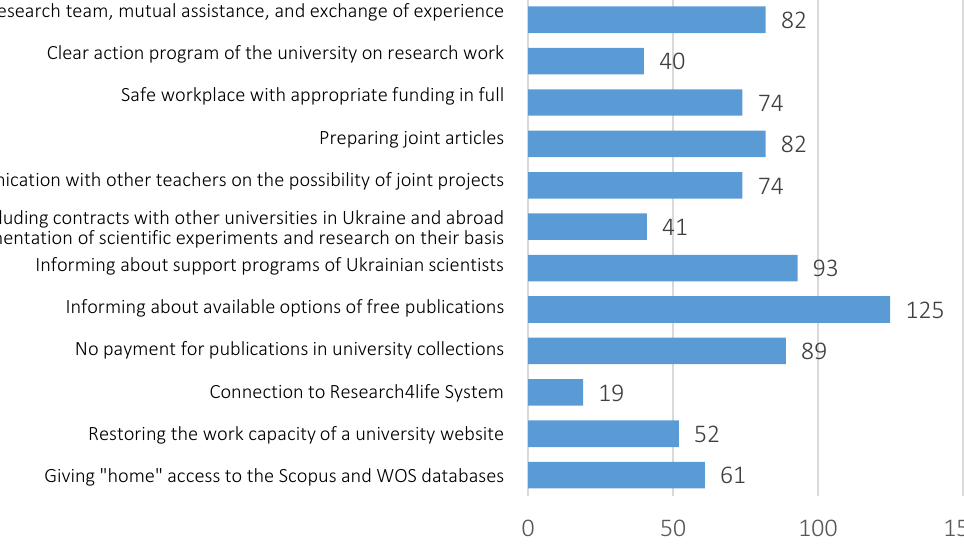
Figure 3. Respondents’ answers to the question “Choose the most relevant and effective response tools to new challenges on research activities during the war”